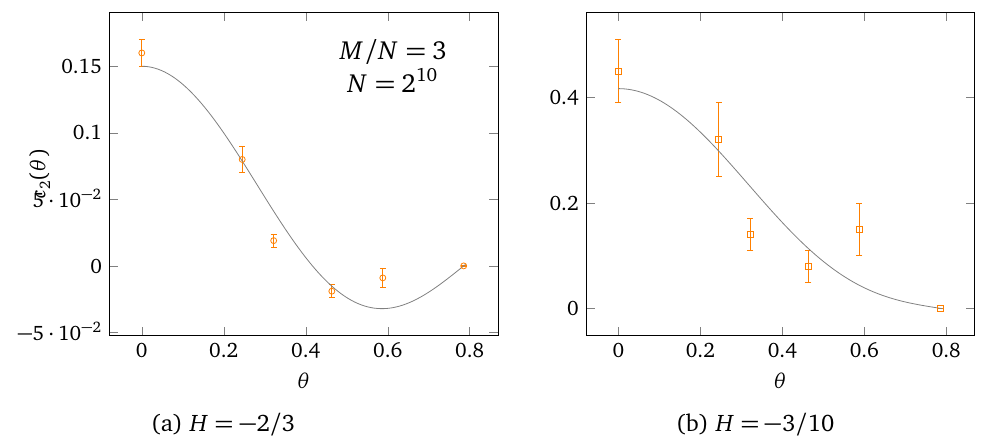
( θ ) from fit (33), for different angles θ , for Figure 12: Values of c 6 H < − 1 / 2 (a) and H > − 1 / 2 (b). The curves are fits to the form (29):